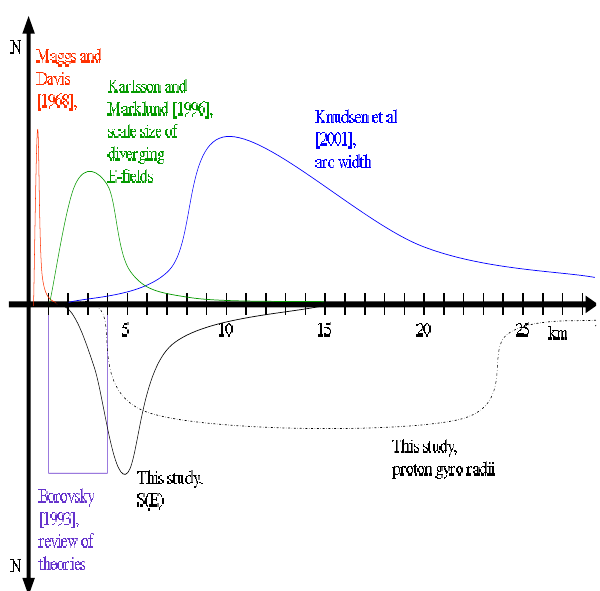
Fig. 9. A sketch summarizing some auroral scale size observations. The optical measurements of arc widths by Maggs and Davis (1968) and Knudsen et al. (2001) are shown in red and blue, respectively. The green line indicates the scale sizes for diverging bipolar electric fields observed by Freja (Karlsson and Marklund, 1996). A majority of the theories reviewed by Borovsky (1993) predicted scale sizes in the range 1–4km; they are here represented by the purple rectan- gle. Results from this study are the solid black line, S(E) , and the dashed-dotted black line, proton